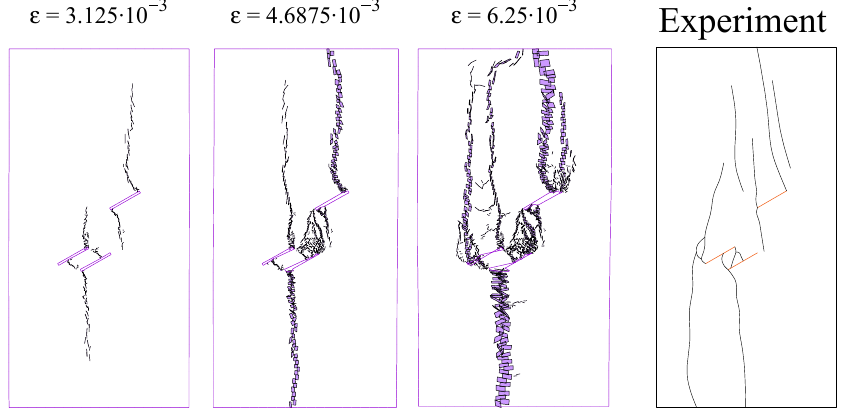
Figure 8. Sandstone containing three pre-existing fissures (Case 2): the crack opening plots (deformation scale 1:1) compared to the experimental results provided in